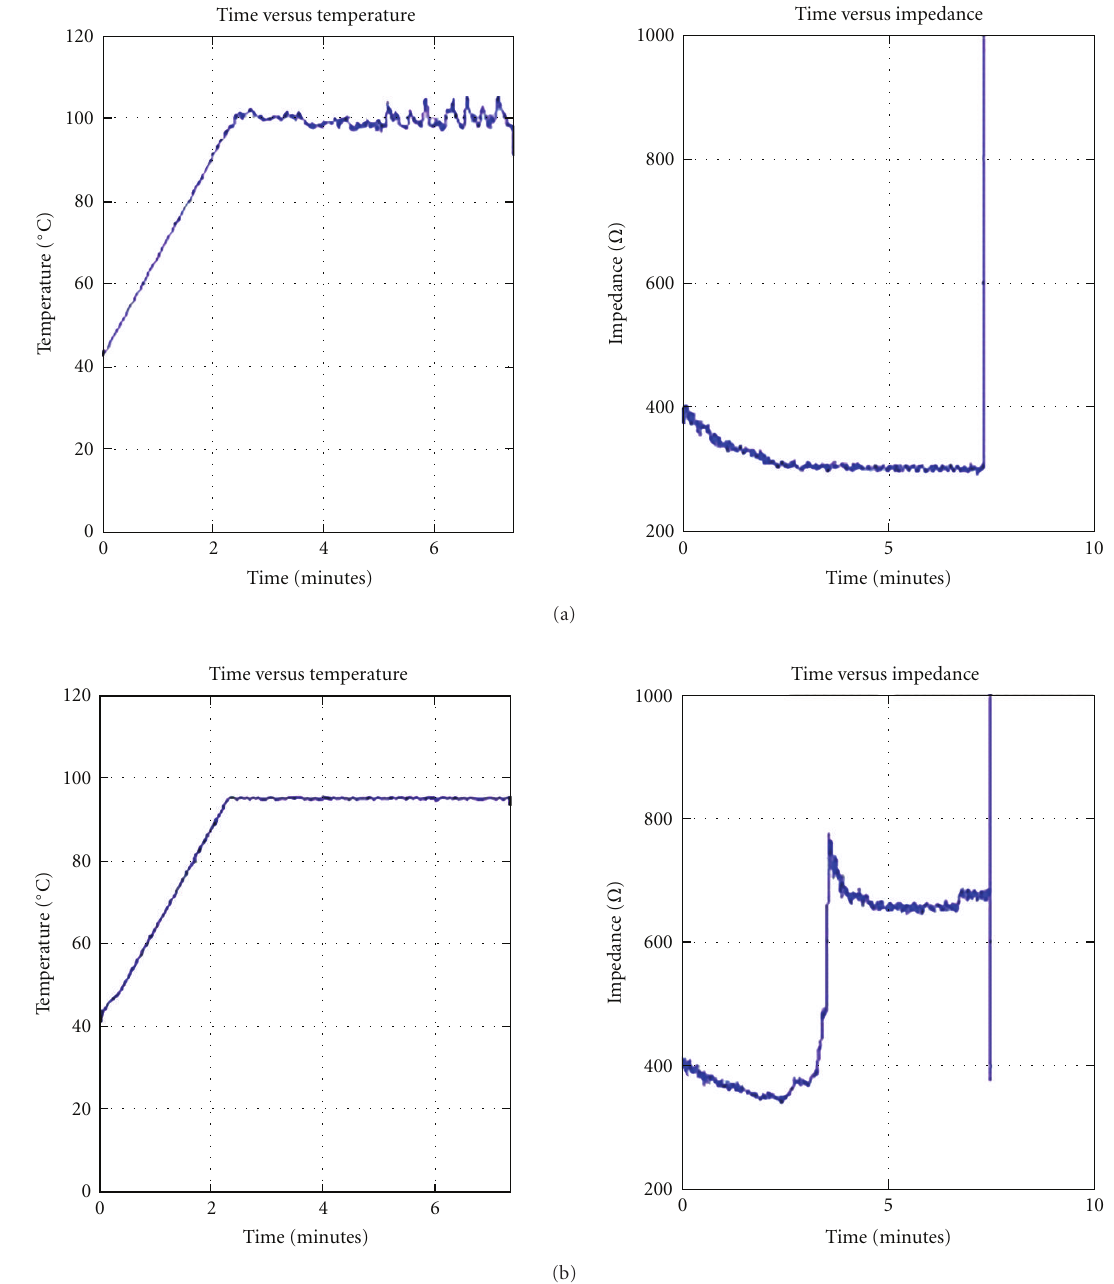
Figure 2: Graphs of probe temperature and impedance against time (a) with no observed rise in impedance and (b) same patient, repeat procedure with observed rise in impedance.